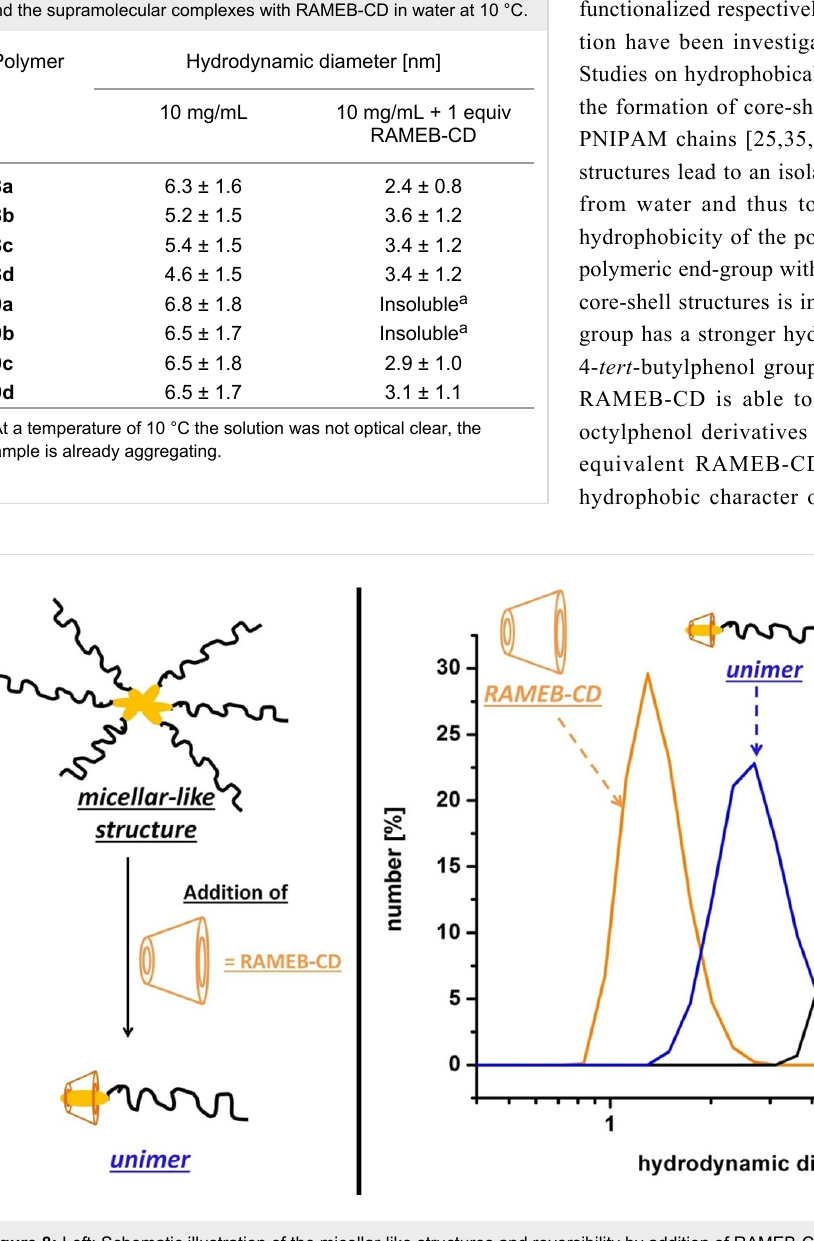
The number averaged hydrodynamic diameters ( d h ) of the poly- mers 8a–d and 9a–d in aqueous solution (concentration: 10 mg/mL; temperature: 10 °C) were determined to 4.6 nm up to 6.8 nm. The addition of one equivalent RAMEB-CD to the of the number averaged hydrodynamic diameter (see Table 3).